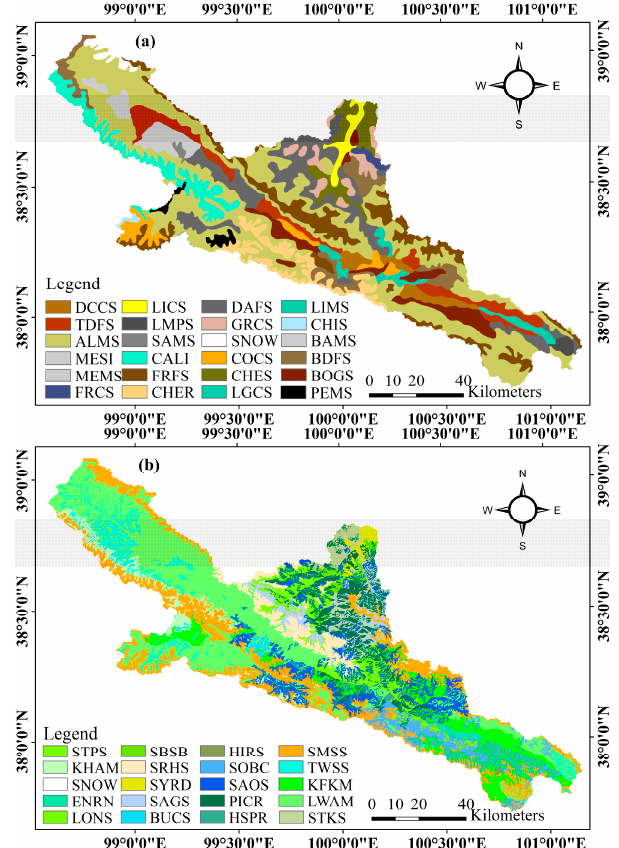
Figure 2. Distribution of soil types ( a ) and land cover types ( b ). Table 1. Code List of Soil Types.